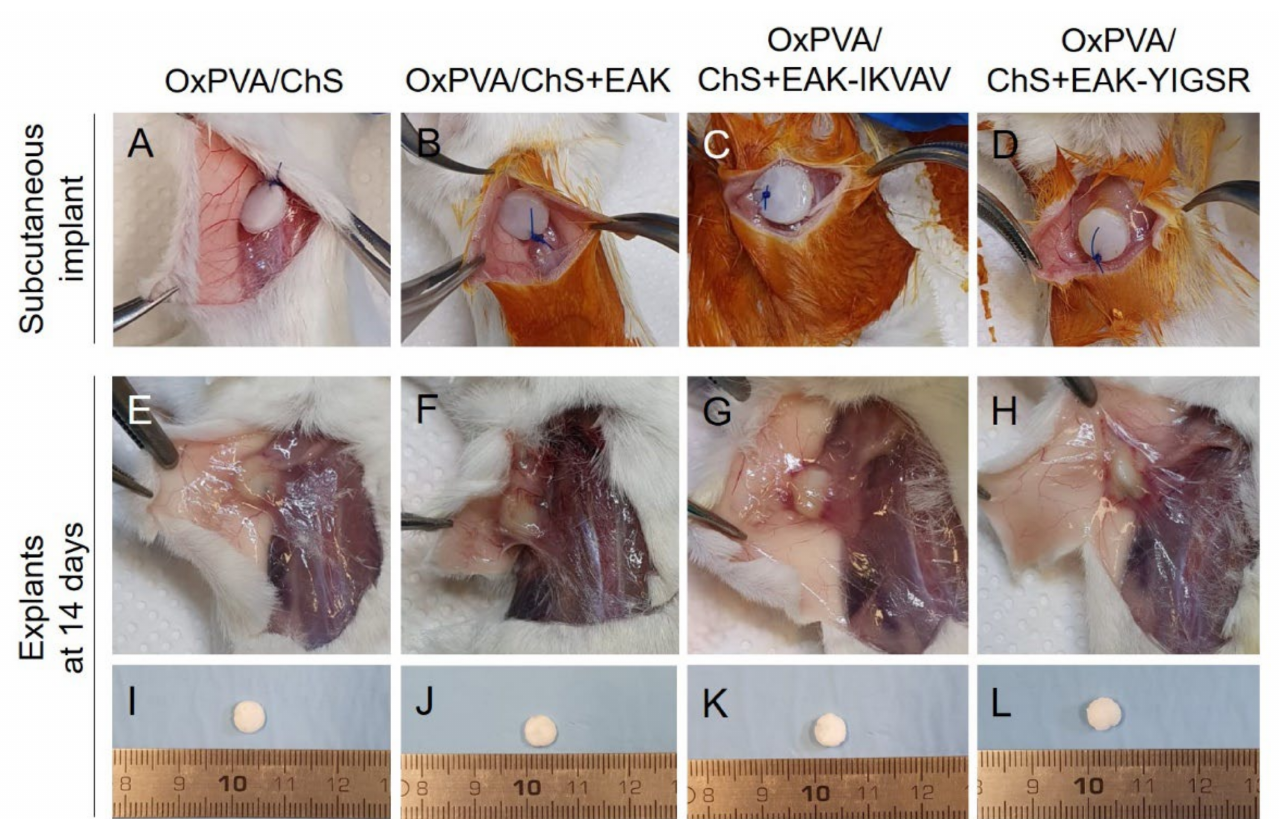
Figure 4. Gross appearance of OxPVA/ChS-based scaffolds grafted into the subcutaneous tissue of BALB/c mice ( A – D ) and 14 days from surgery, at the implant site ( E – H ) and after sample excision ( I – L